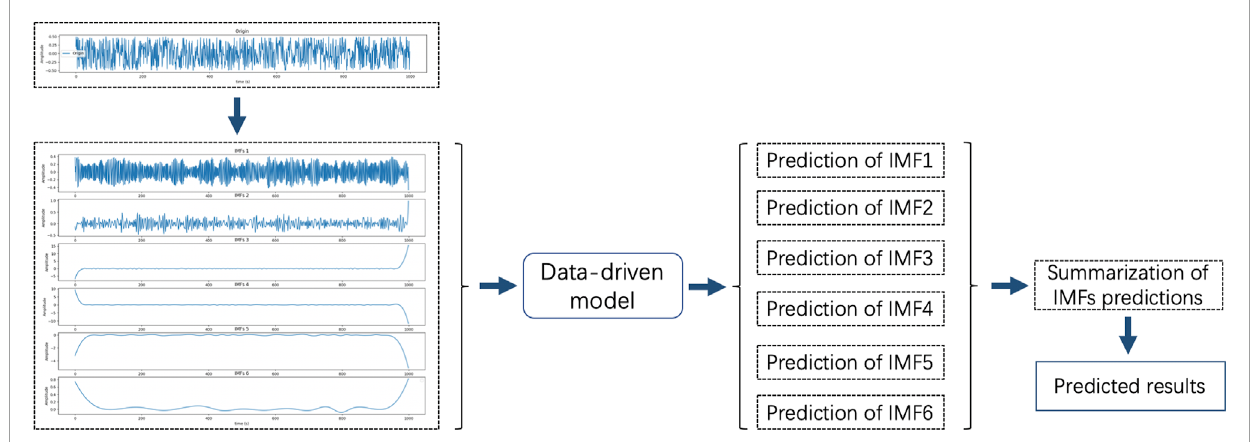
FIGURE 11 Signal decomposition schematic, the input data is decomposed into multiple sub-signals Z SD1 to ZSDn by the signal decomposition algorithm. The sub-signal input data-driven model results are combined to obtain the prediction